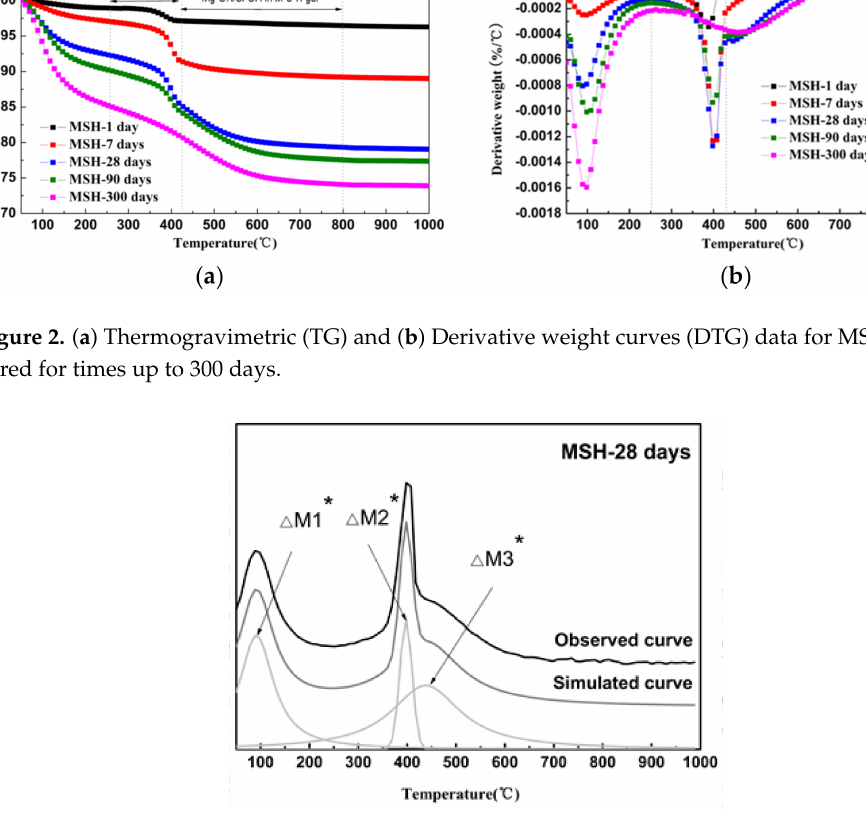
Figure 3. De-convolution of the DTG curves of MSH 28 day sample. The black line is the experimental data. The dark gray line is the global fitting curves and the light gray lines represent the Gaussian peaks on the x-axis obtained by the fitting